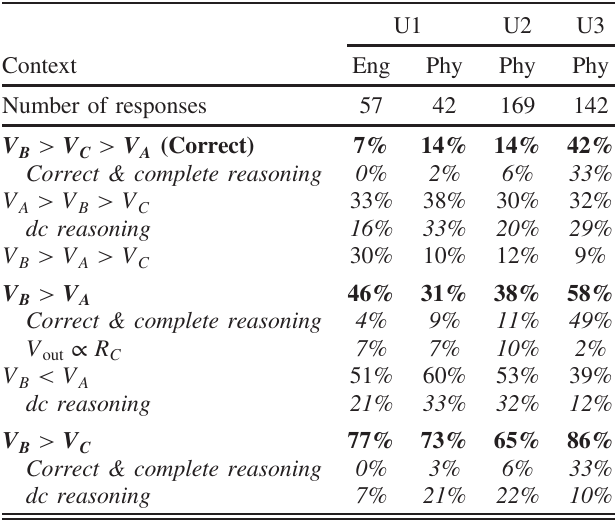
TABLE II. Overview of student performance on the transistor amplifier comparison task (shown in Fig. 3). Correct rankings and comparisons are indicated by bold